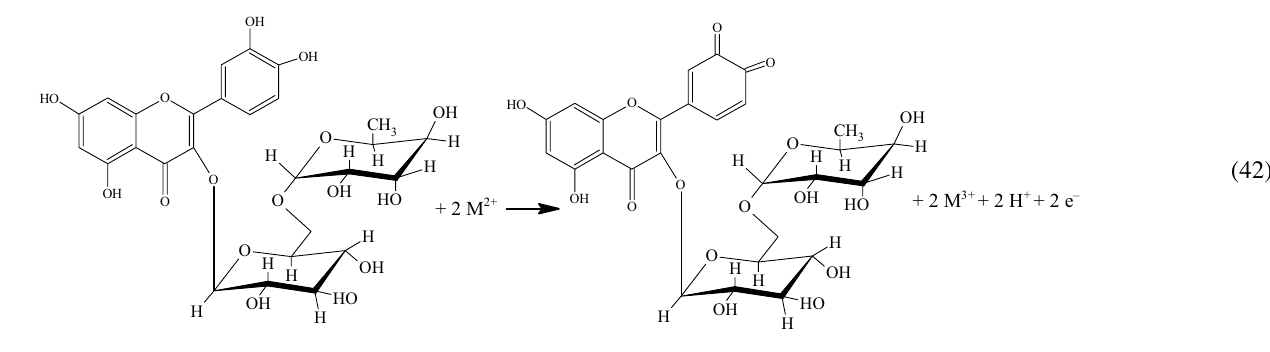
Nickel/cobalt oxide-decorated 3D graphene